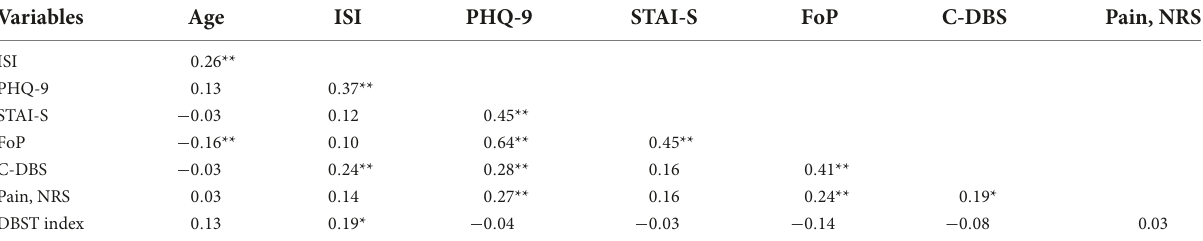
TABLE 1 Correlation coefficients among rating scale scores and the DBST index among patients with cancer ( n =